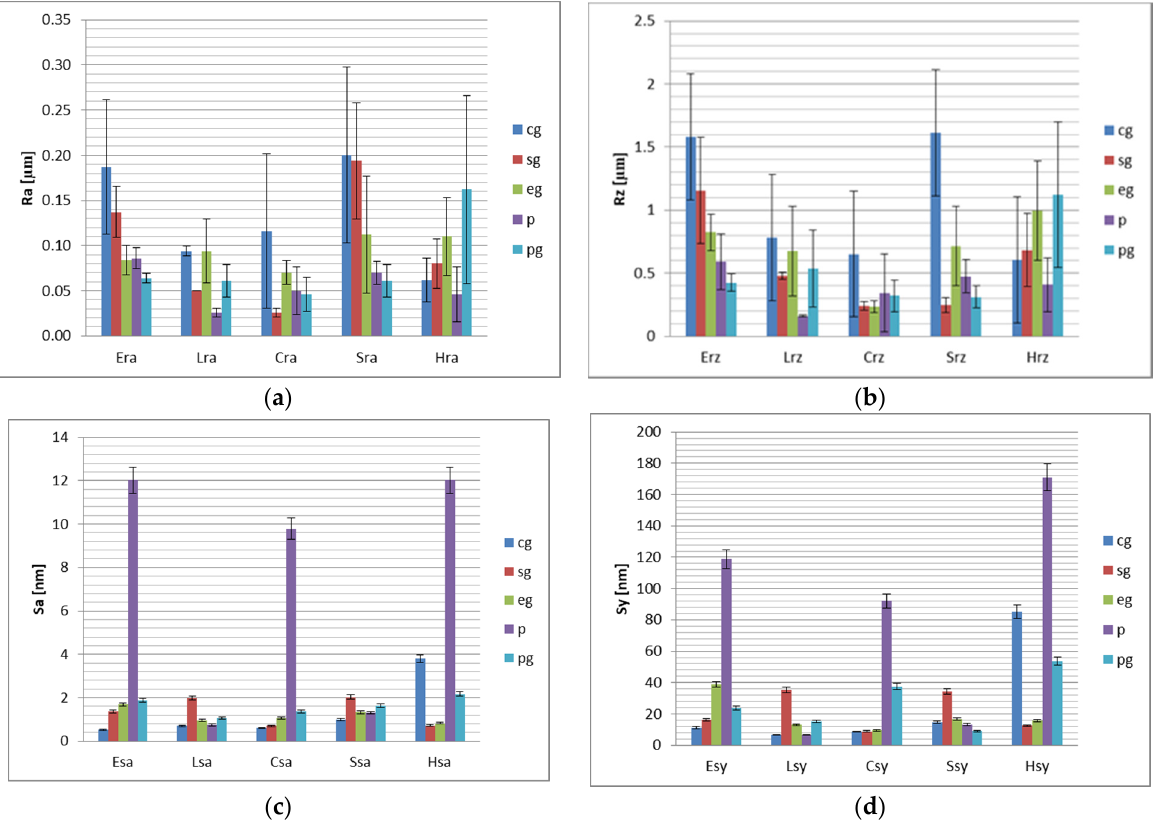
Figure 2. Surface roughness values of the samples, related to the finishing method. ( a ) R a (average surface roughness) for the finished resin-composite samples, ( b ) R z values (maximum surface roughness) for the finished resin-composite samples, ( c ) S a (average nanoroughness) for the finished resin-composite samples, ( d ) S y (amplitude of heights) for the finished resin-composite samples.